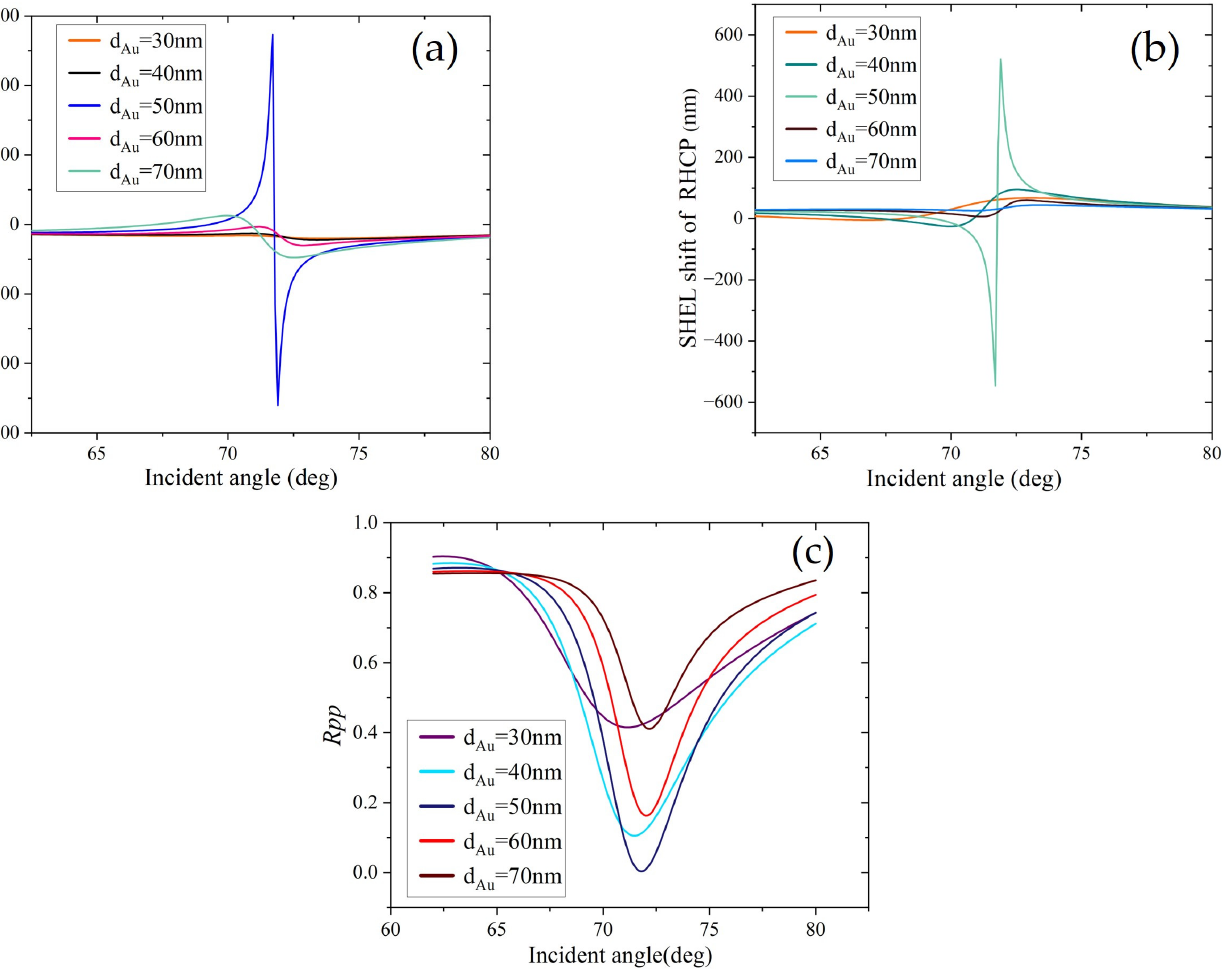
Figure 4. ( a ) Variation of SHEL shift of LHCP component with the incident angle, at different thickness of gold layer; ( b ) variation of SHEL shift of RHCP component with the incident angle, at different thickness of gold layer; ( c ) variation of reflection coefficient R with the incident angle, at different thickness of gold layer.